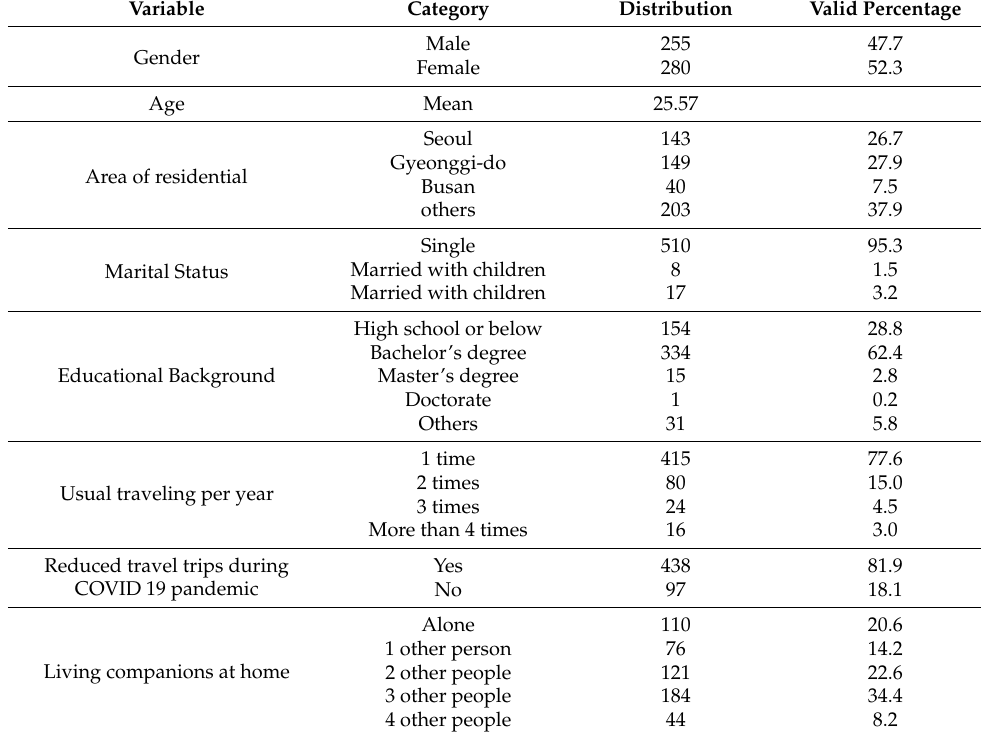
Table 1. Demographic